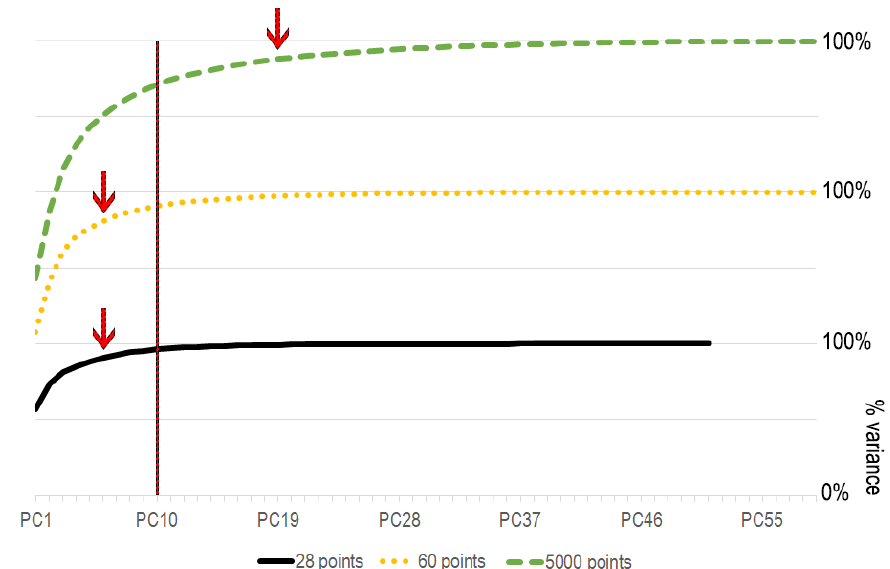
Figure 7. Cumulative variability chart (28 points, 60 points, 5000 points). The red line marks the first ten principal components. The red arrows show where the PCs represents more than 90% of the